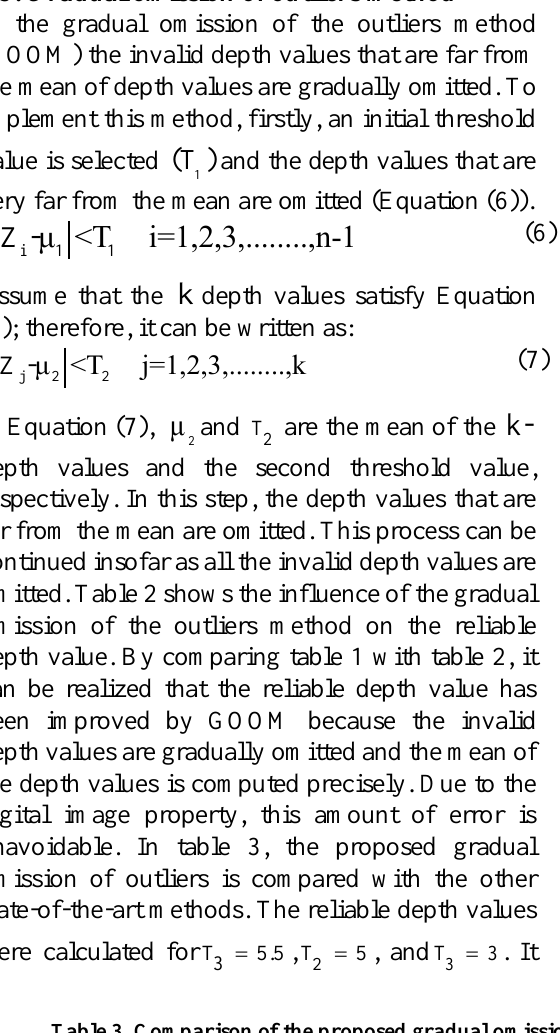
Table 3. Comparison of the proposed gradual omission of outliers method with the other methods for "Collection".